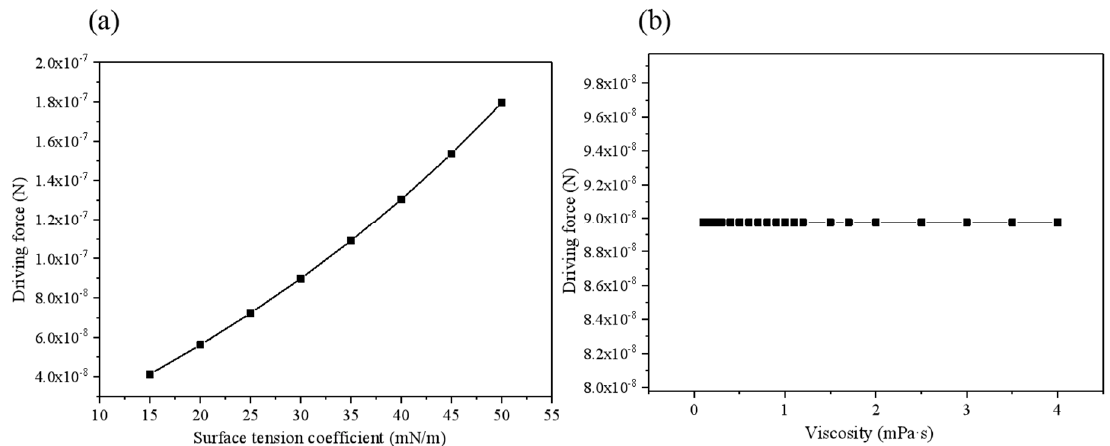
Figure 8. Relationship between driving force and ( a ) surface tension coefficient ( b ) fluid viscosity.